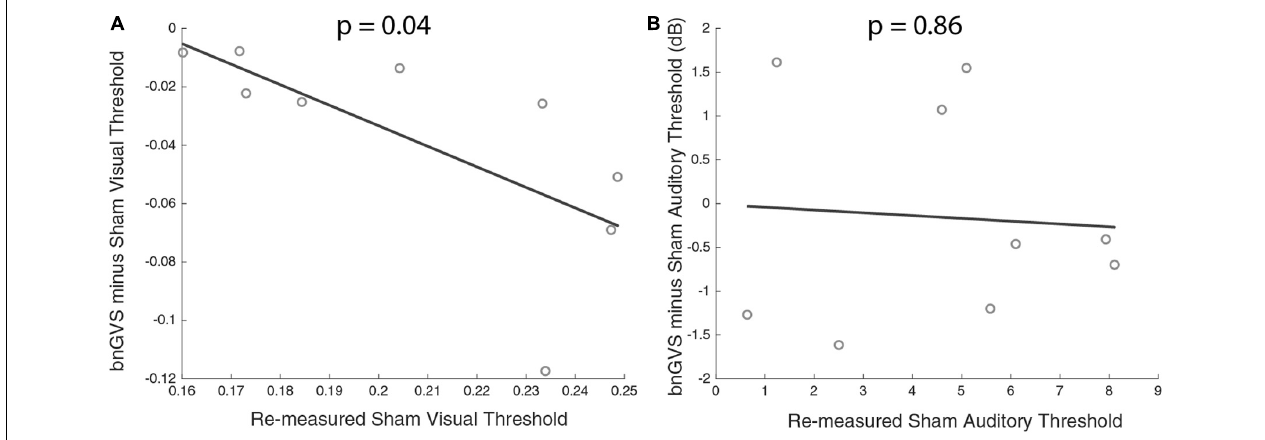
FIGURE 7 | Scatterplots of sham threshold against improvement (negative difference indicating improved threshold) with line of best fit. (A) Visual contrast thresholds. (B) Auditory thresholds. Correlation between improvement and sham threshold was only found in visual contrast